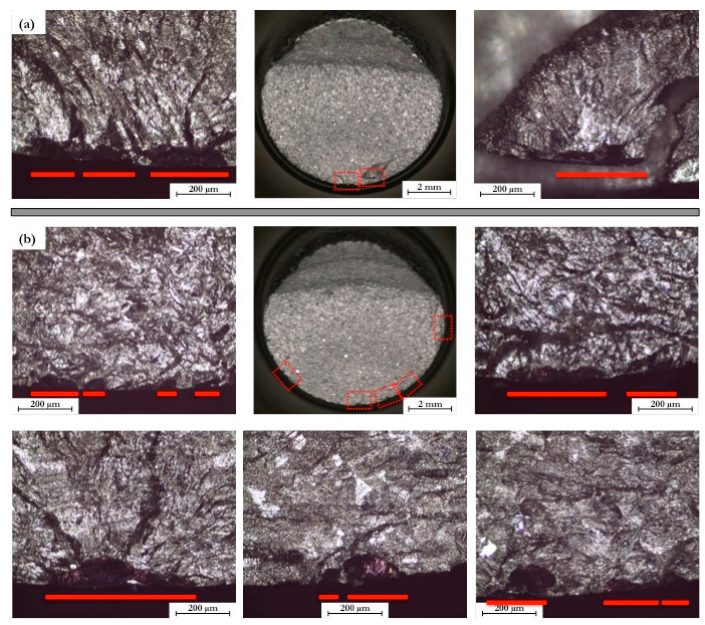
Table 3. Quantitative damage measurements for tests in air interrupted after 1350 cycles with SIS A and SIS B signals.